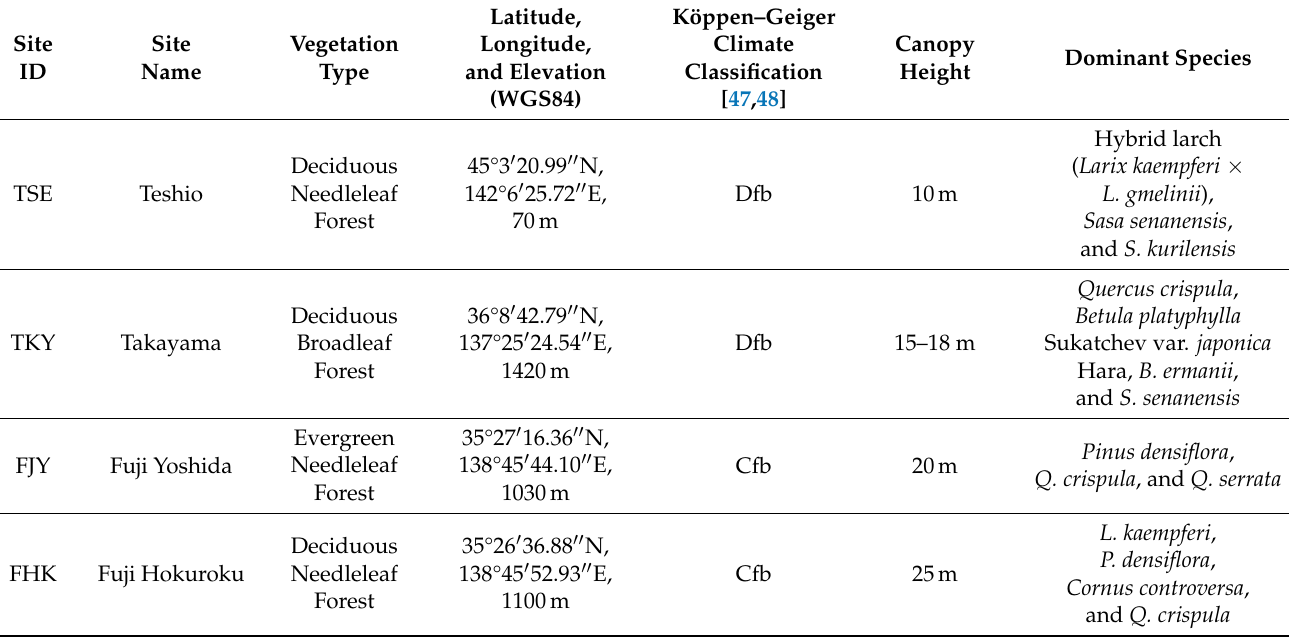
Figure 2. Overviews of the four study sites. The silvery artificial structure in each photo is the observation tower. The date next to the site name indicates when we took each photo. Table 1. Specifications of four study